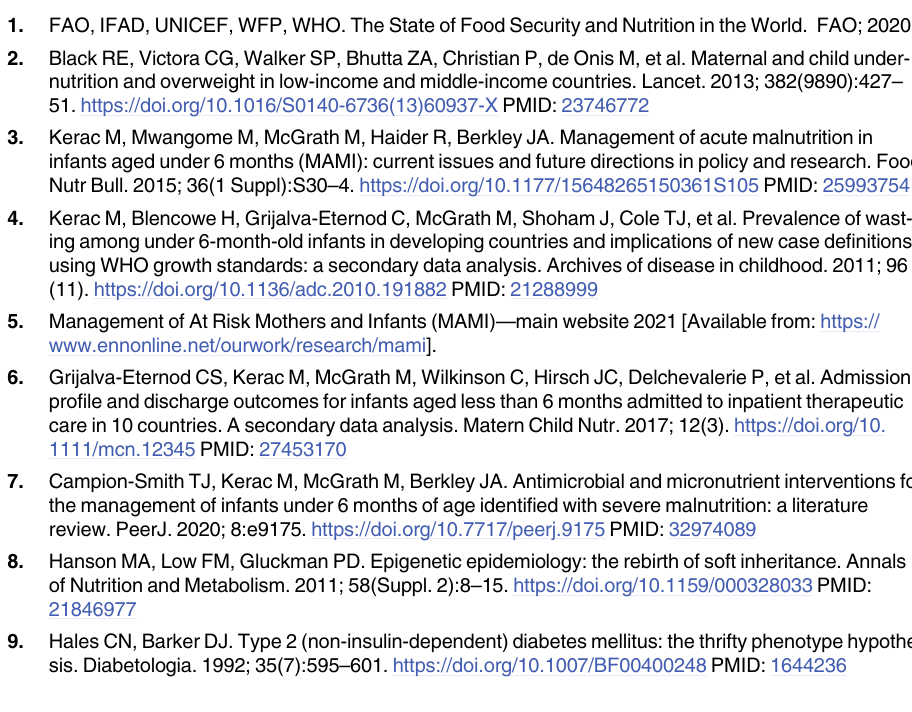
S2 Table. GRADE quality assessment for maternal non-supplementation interventions during lactation and pregnancy–reviews. S3 Table. GRADE quality assessment for maternal supplementation interventions during lactation and